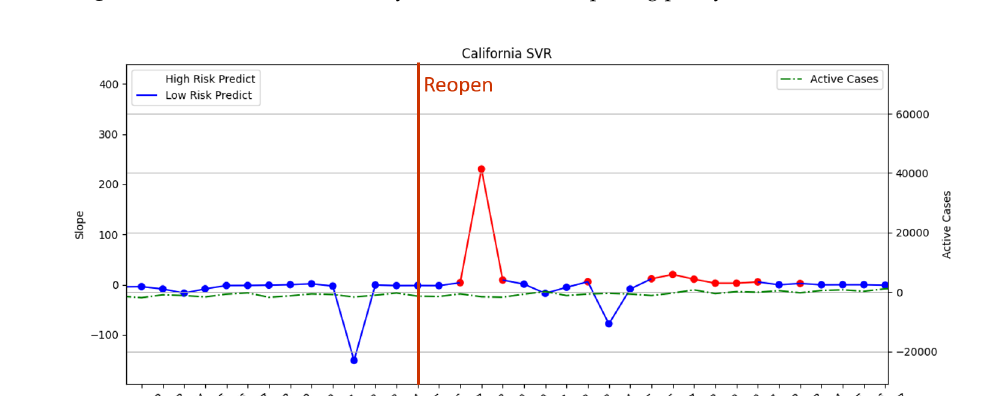
Figure 23. The result of risk analysis with PR for reopening policy in California.